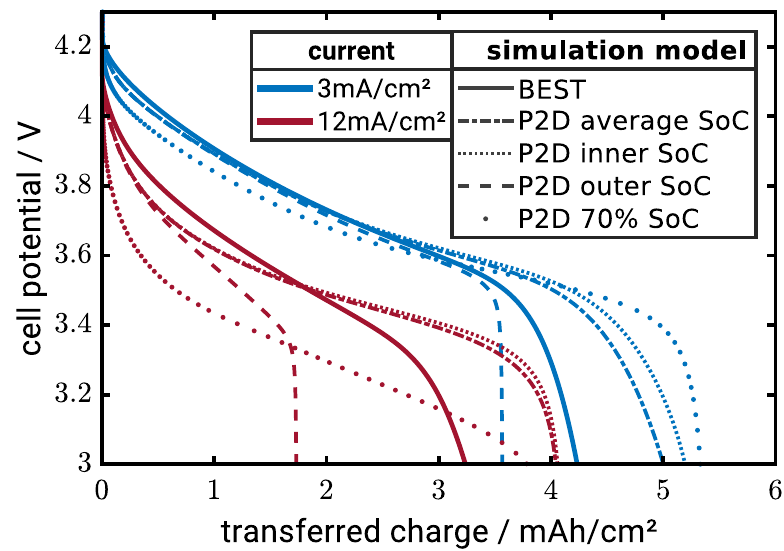
Figure 9. Comparison of BEST-simulations with the homogenized models for electrodes with 60 vol-% CAM ( d 50 = 10µm) and no additional CBD. Line styles represent the different models for the calculation of the effective particle conductivity.